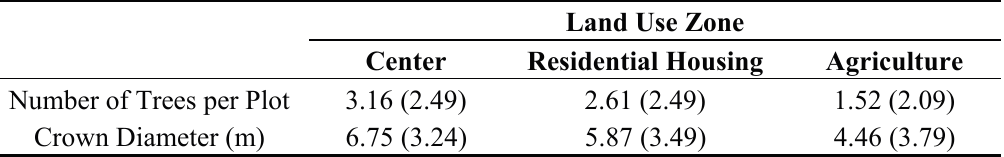
Table 2. Mean and standard deviation of number of trees per plot and crown diameter (m) by land use zone. Standard deviations in parentheses. All zones are significantly different from each other (0.05 confidence) for both number of trees per plot and crown diameter. For number of trees per plot n = 2181, for crown diameter n =